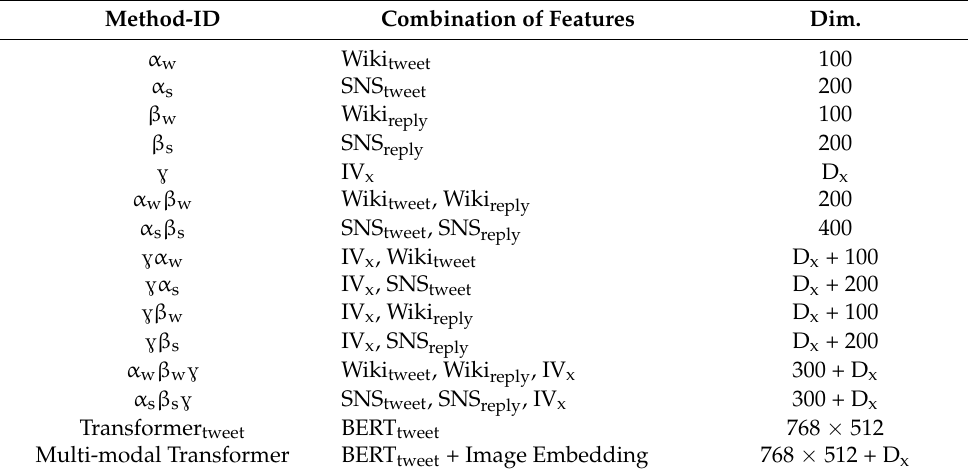
Table 3. Combinations of features used in the baseline